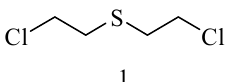
Figure 1. Sulfur mustard